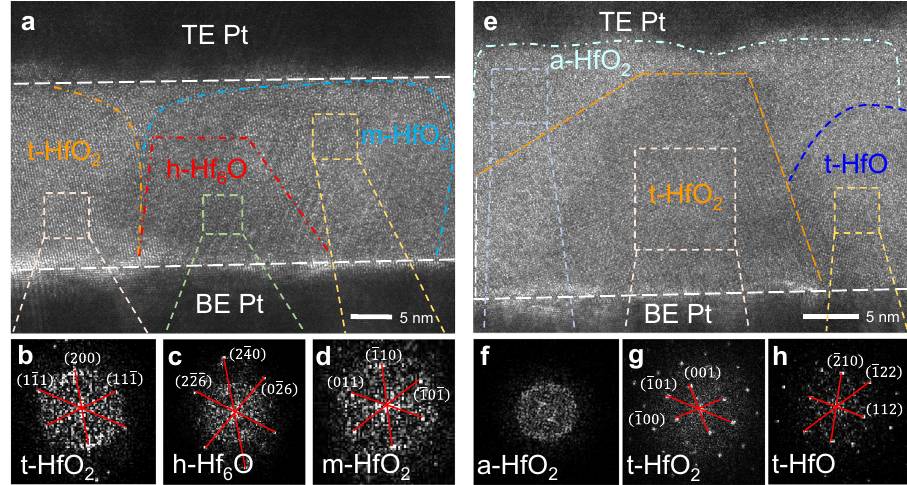
Fig. 3 Emergence of t-HfO 2 around the ruptured h-Hf 6 O CFs, which suffered a RESET process. a HRTEM image of the remaining ruptured h-Hf 6 O CF (in red) in the HRS Pt/HfO 2 /Pt RS memristor with both sides enclosed by t-HfO 2 (in orange) and m-HfO 2 (in blue), as con fi rmed by their typical FFT diffraction patterns in b – d . e HRTEM image of another ruptured CF region, where only t-HfO 2 (in orange), a-HfO 2 (in light blue), and t-HfO (in dark blue) are observed, while the CF is completely ruptured, as con fi rmed by their FFT diffraction patterns in f – h